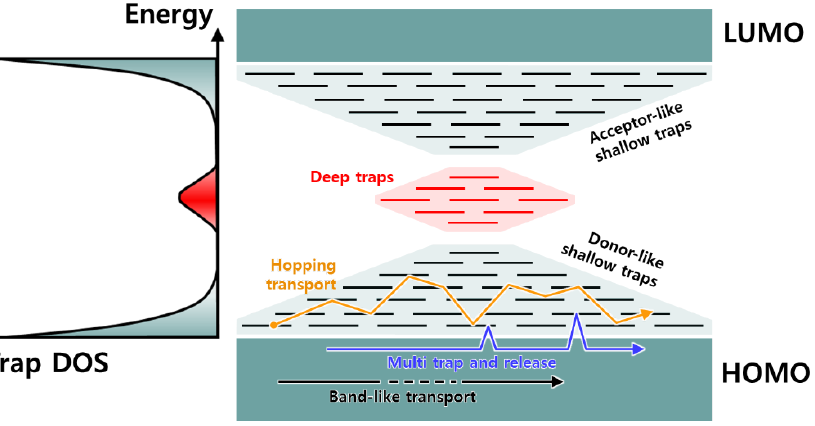
Figure 6. Schematic diagram of trap DoS function and corresponding trap states (shallow trap and deep trap).